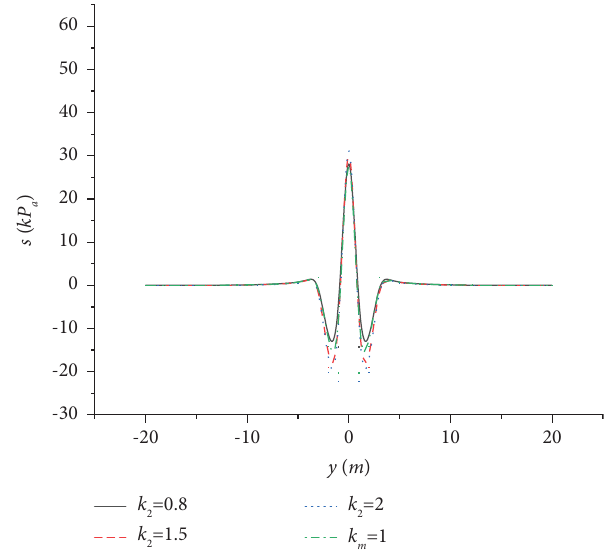
Figure 11: Contact stress curves in y- direction due to E